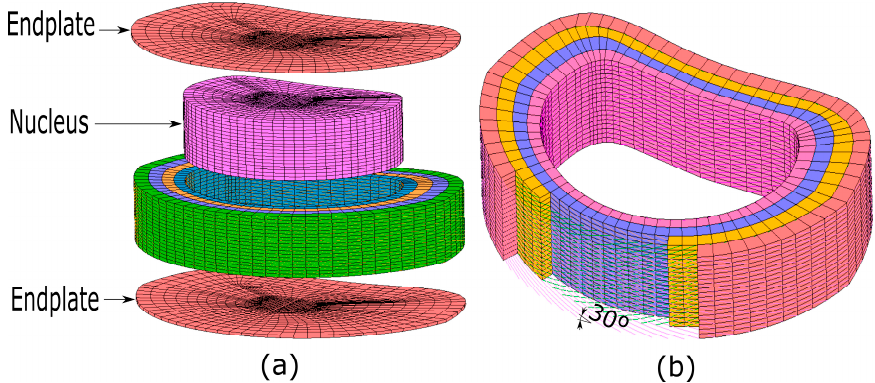
and annulus fibrosus; and ( b ) details of the orientation of the five different fiber